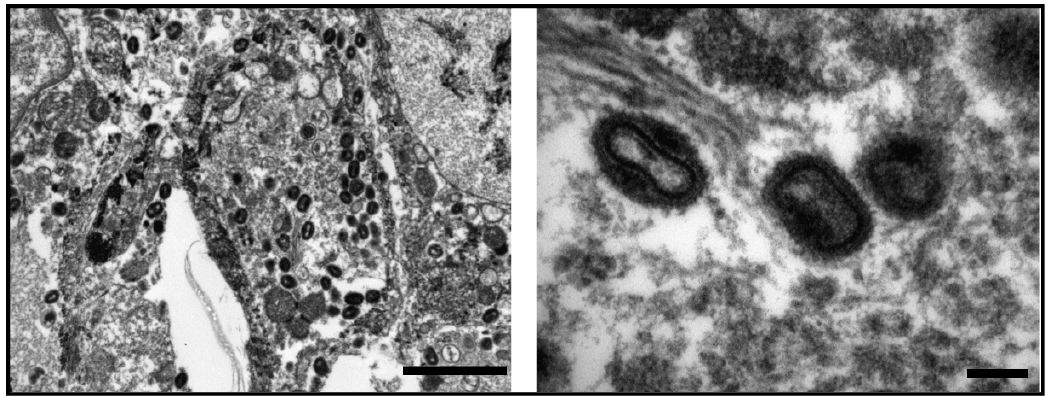
Figure 2. Electron microscopy of specimen V563 showing large numbers of typical orthopoxvirus particles at different magnification. Scale bars correspond to 2 micrometers ( left ) and 200 nm ( right ).